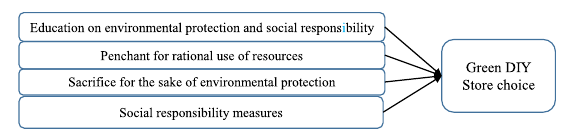
Fig. 1 The investigated model. Source: own